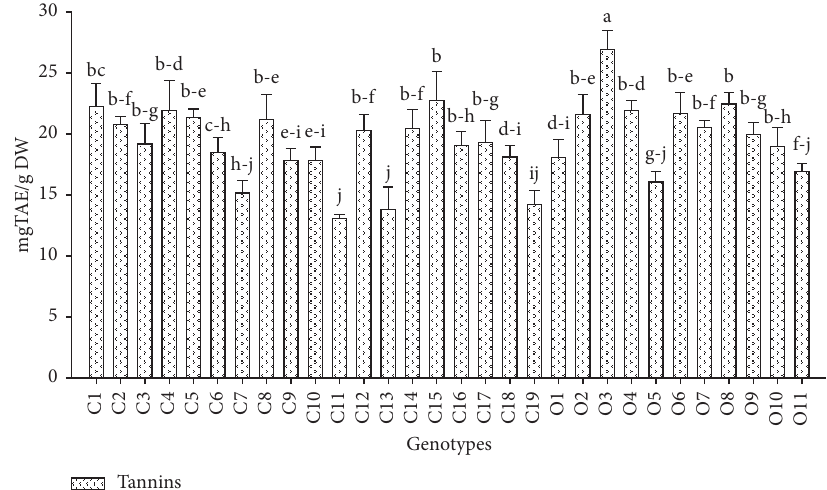
Figure 3: Variation in the content of total